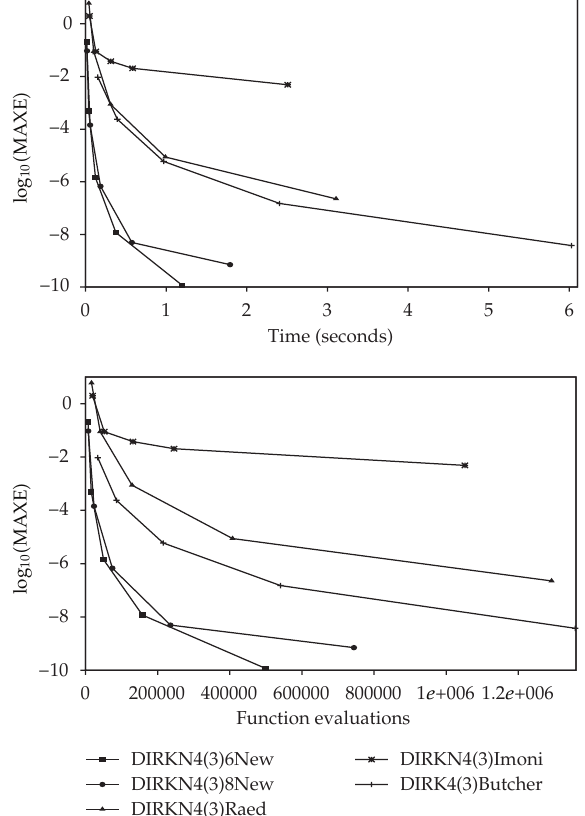
Figure 7: E ffi ciency curves for Problem